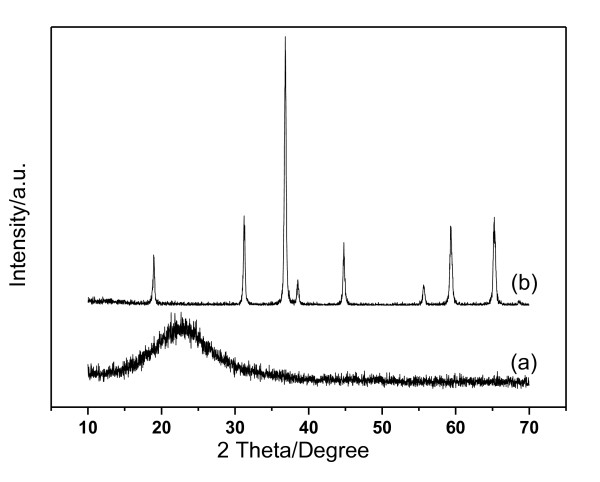
XRD pattern of Co-SiO2 (a) and C-Co3O4 (b).